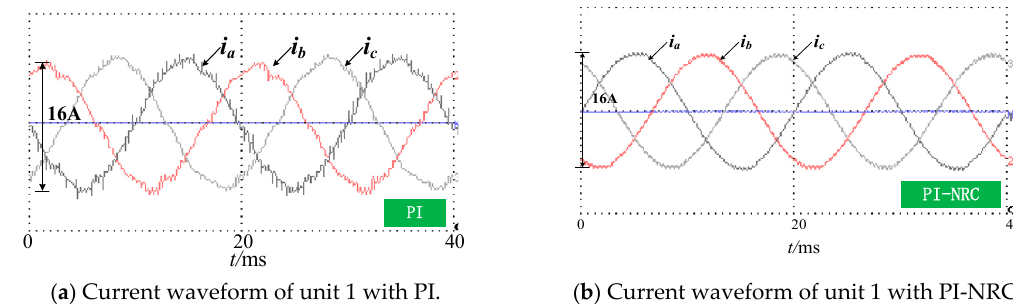
( a ) Current waveform of unit 1 with PI. ( b ) Current waveform of unit 1 with PI-NRC. Figure 17. Current waveform of generator unit 1 with different controllers at 500 r/min. Figure 17. Current waveform of generator unit 1 with di ff erent controllers at 500 r /